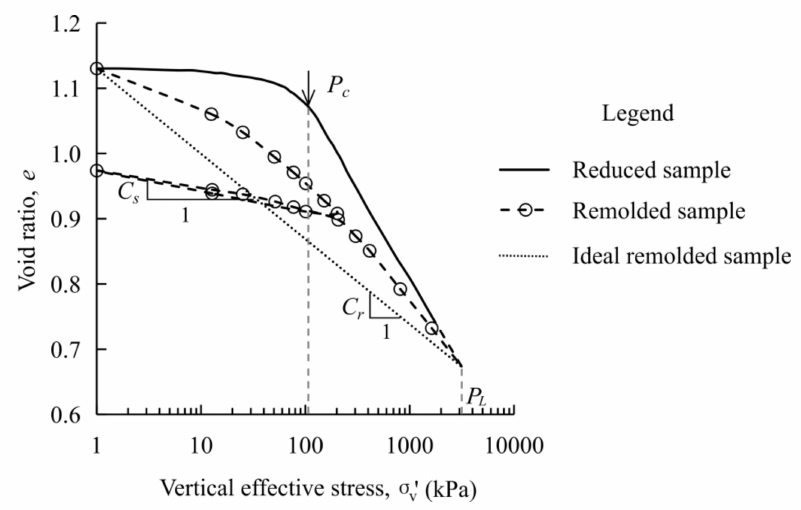
Figure 6. The reduced compression curve after